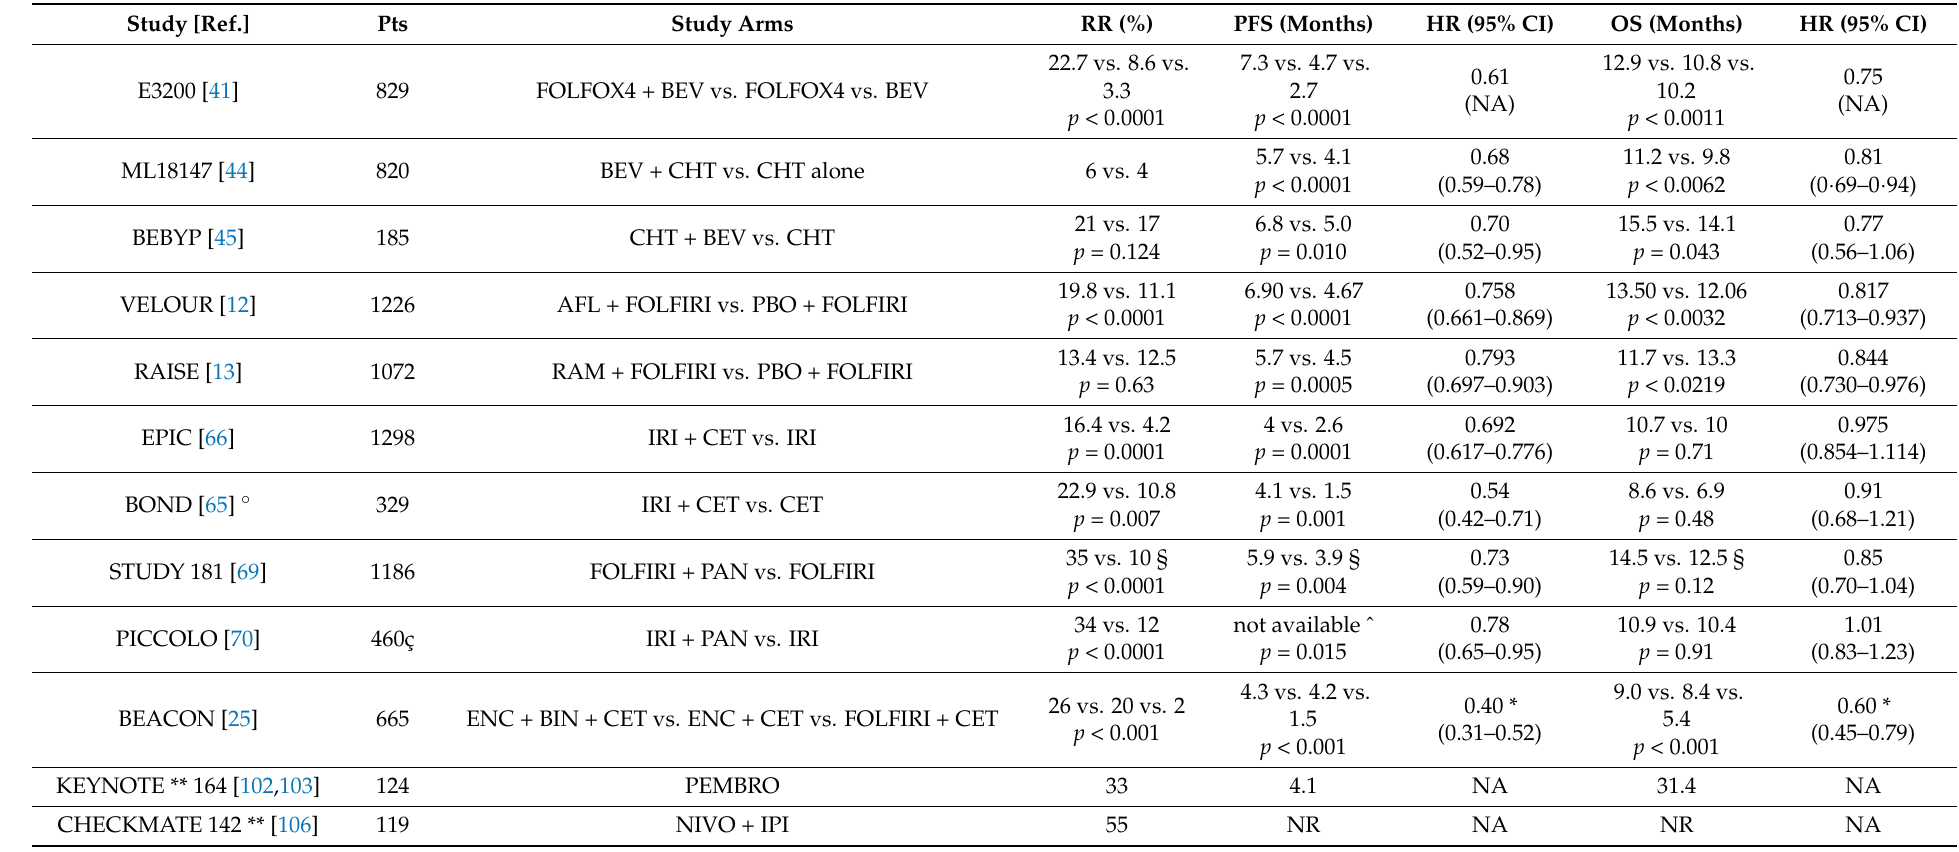
Table 2. mCRC second-line phase II and phase III pivotal